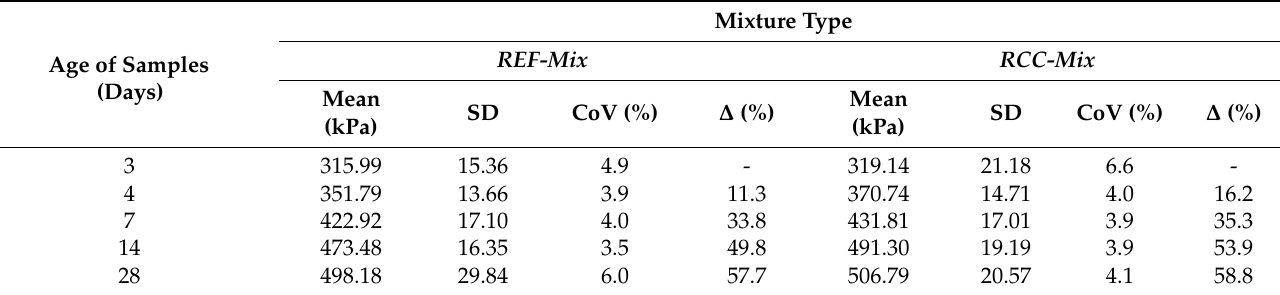
Figure 14. Results of the unconfined compressive strength tests on the samples from the REF-Mix and RCC-Mix mixtures as a function of specimen age. Table 13. UCS test results of the samples from REF-Mix and RCC-Mix mixtures (mean—mean value, SD—standard deviation of the sample, CoV—coefficient of variation, ∆ —increase of unconfined compressive strength)